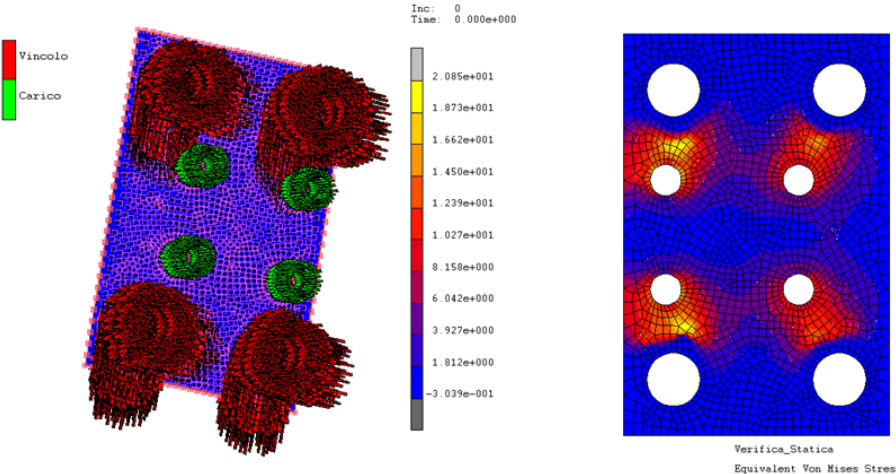
Figura 4: Schema per l’analisi FEM; Von Mises